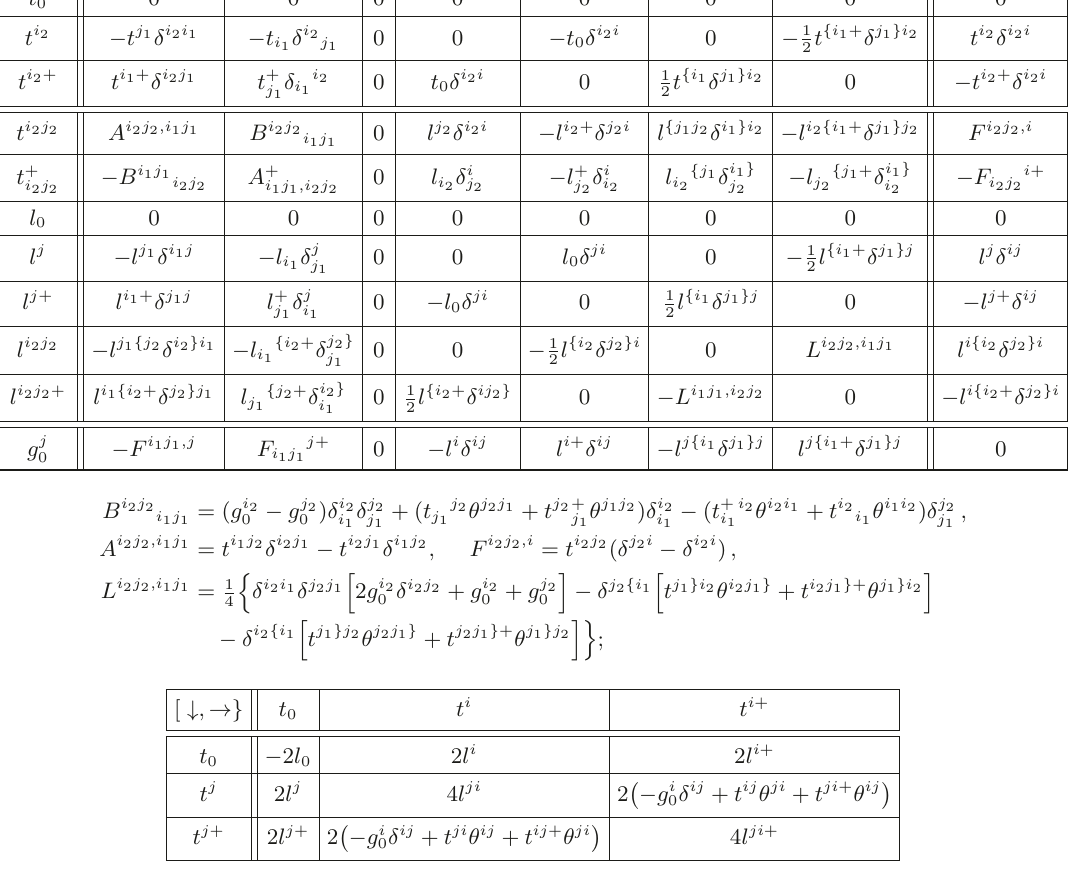
f ( Y ( k ) , R 1 ,d − 1 ). A